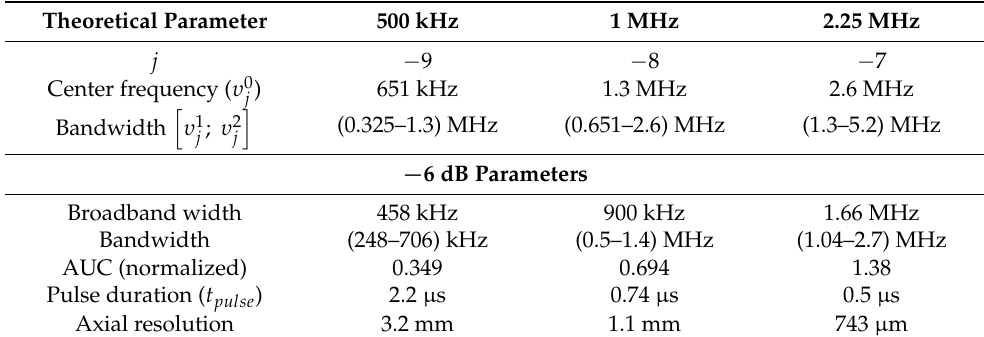
Table 3. Time and frequency (theoretical and − 6 dB) parameters of the theoretical analyzing wavelets. The scale j was determined for each transducer with the sampling frequency F e = 500 MHz, and a number of samples N = 65,536.